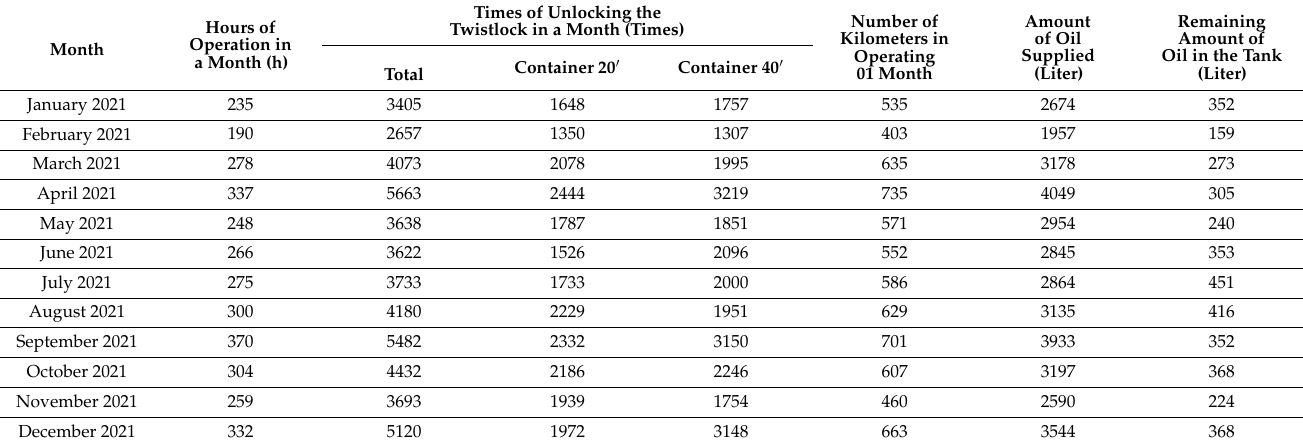
Table 5 provides data on operation of a surveyed container lift-on/-off vehicle by month. Table 5. Data on monthly operation of Nam Dinh Vu terminal’s lift-on/-off vehicle during 12